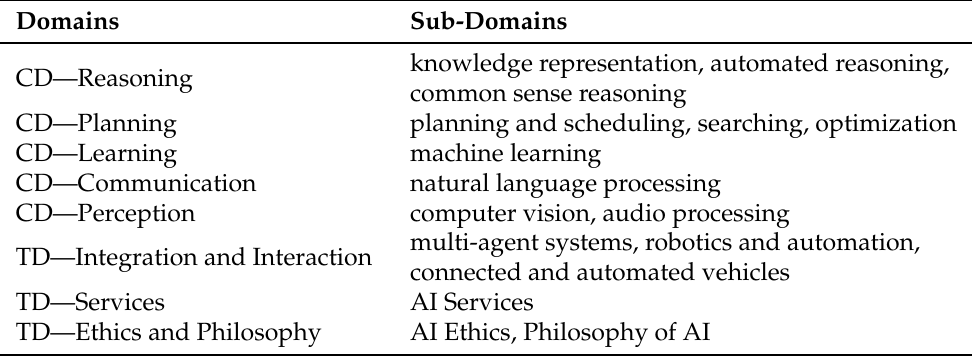
Table 1. AI Core and Sub-Domains.